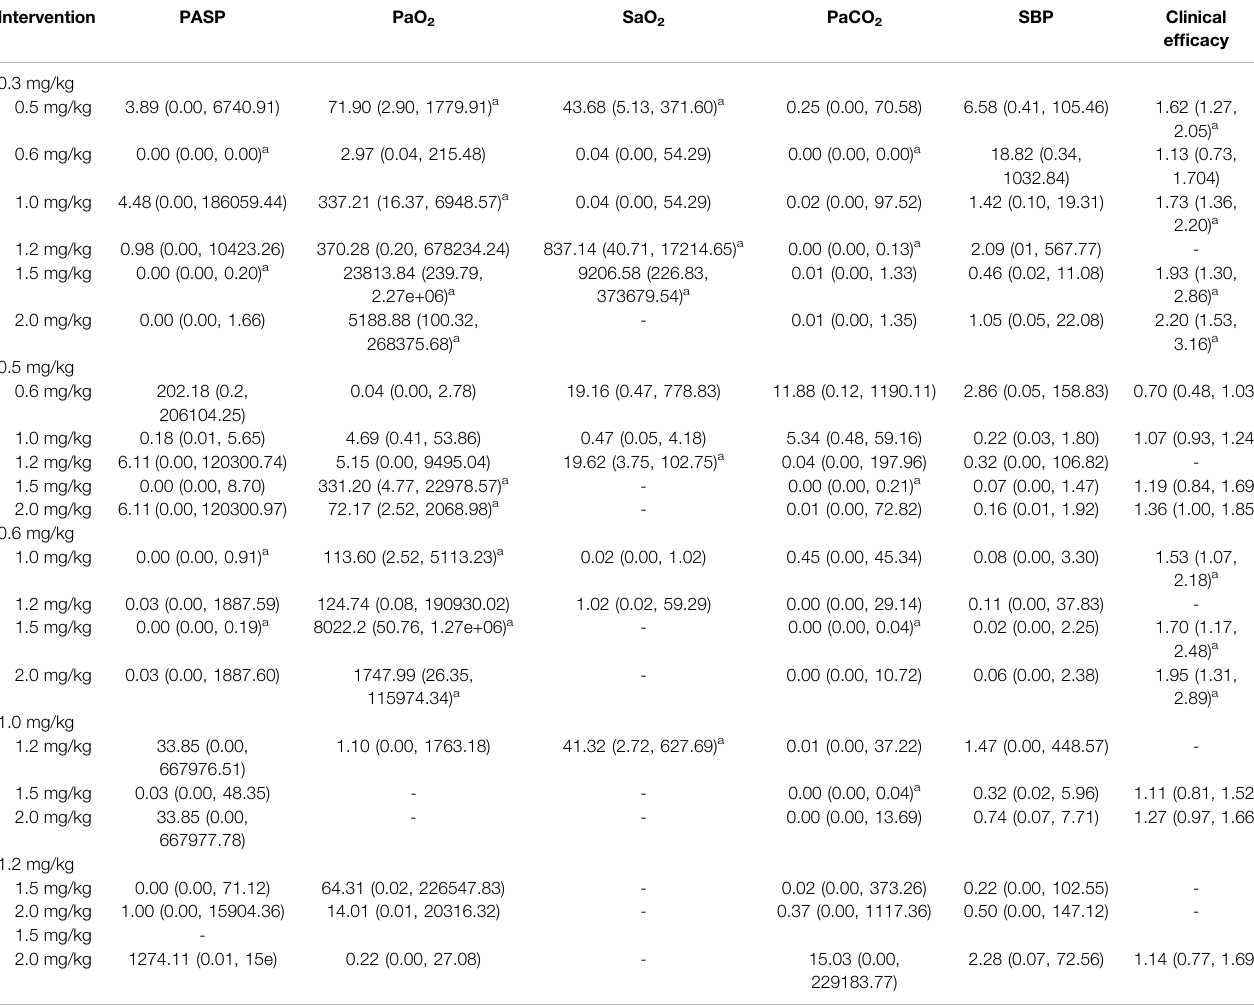
TABLE 2 | Pairwise comparisons of the ef fi cacy of different doses of sildena fi l for PPHN. Intervention PASP PaO 2 SaO